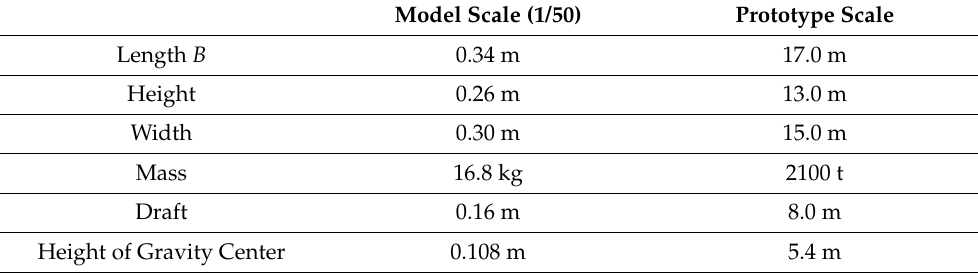
Table 2. Specifications of the footings.